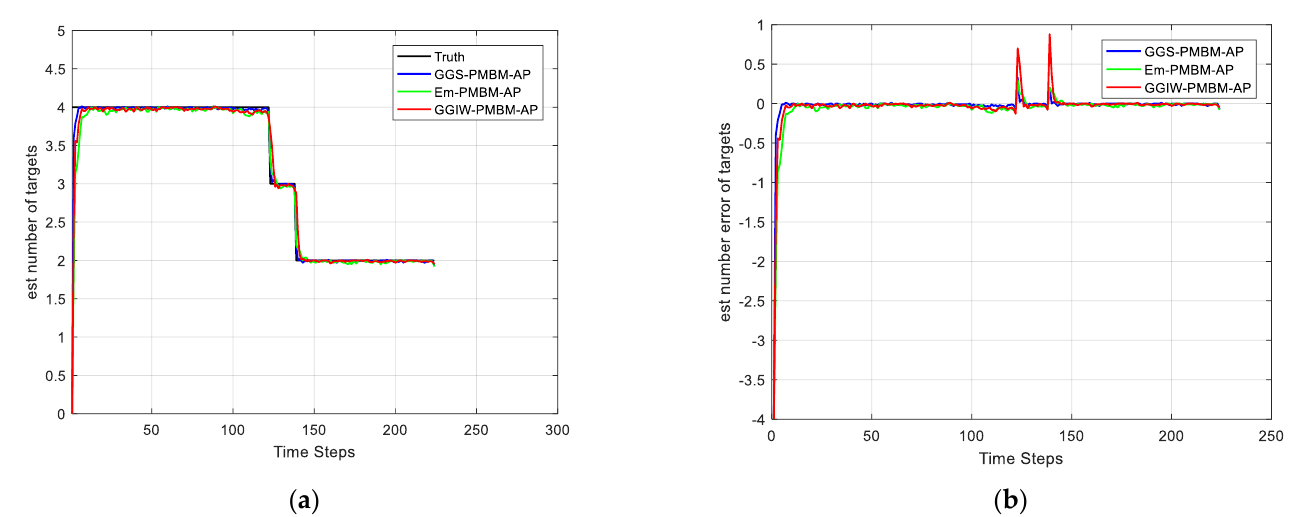
Figure 12. Averaged cardinality and cardinality error of the GGS-PMBM-AP filter, Em-PMBM-AP filter and GGIW-PMBM-AP filter over 100 Monte Carlo runs. ( a ) Estimated number of targets, ( b ) cardinality error of targets estimation.